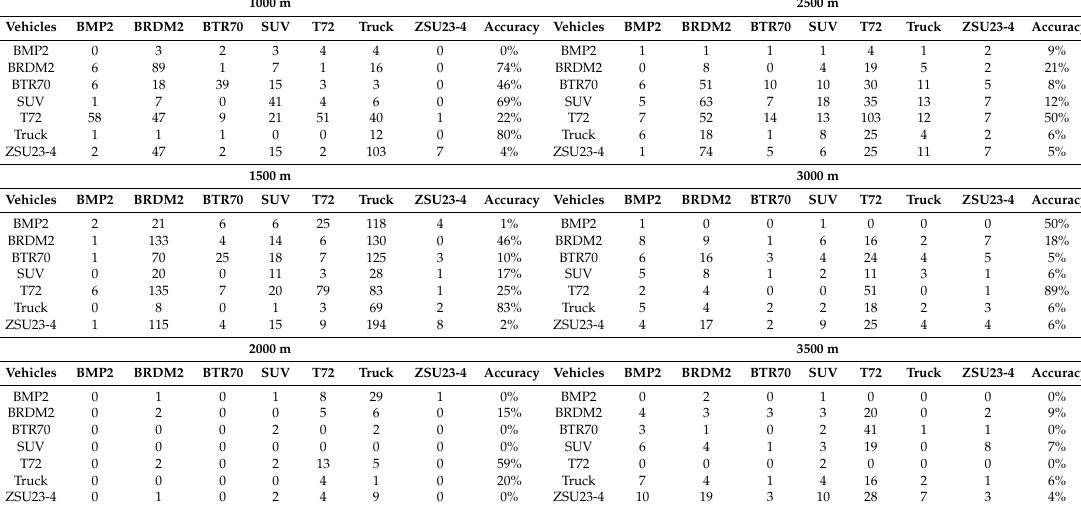
Table A8. Classification results for PCE 25 (MWIR daytime) case. Left shows the confusion matrix and the last column shows the classification accuracy.